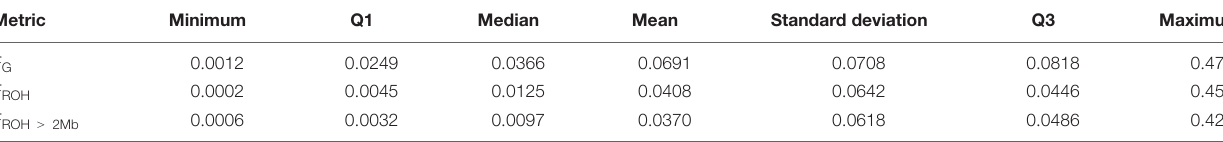
TABLE 1 | Overall descriptive statistics of F ROH , F ROH > 2Mb , and F G metrics ( N = 60). Metric Minimum Q1 Median Mean Standard deviation Q3